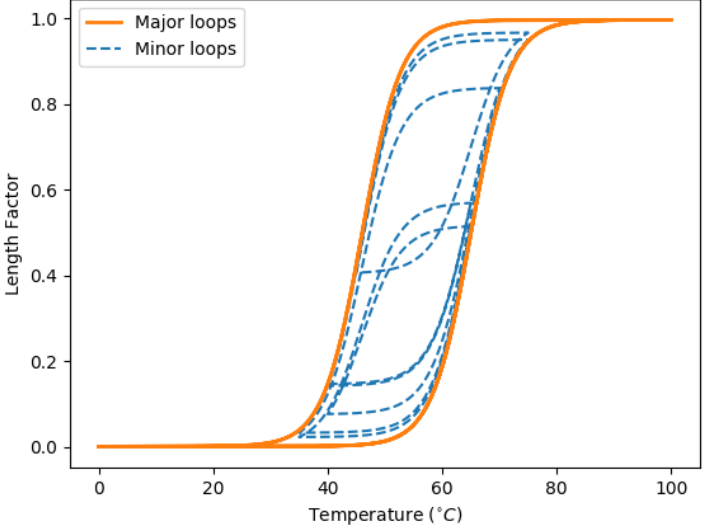
Figure 2. An illustration on the hysteresis loops of SMA